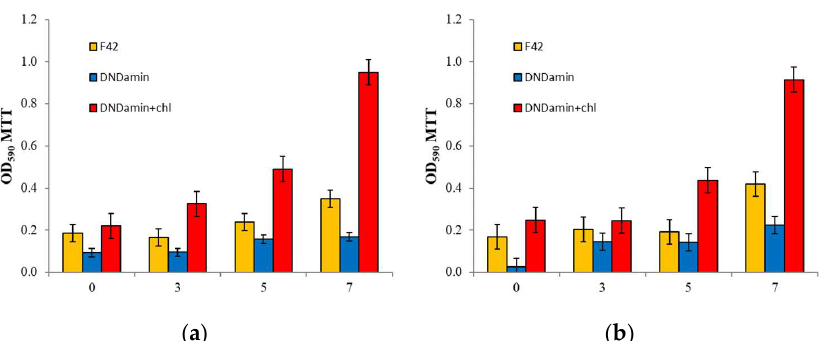
Figure 7. Respiratory activity of cells on the samples (MTT assay optical density) after 1.5 h, 3, 5 and 7 days: ( a ) In vitro incubation with culture of the Saccharomyces cerevisiae ; ( b ) in vivo incubation in a fish tank.